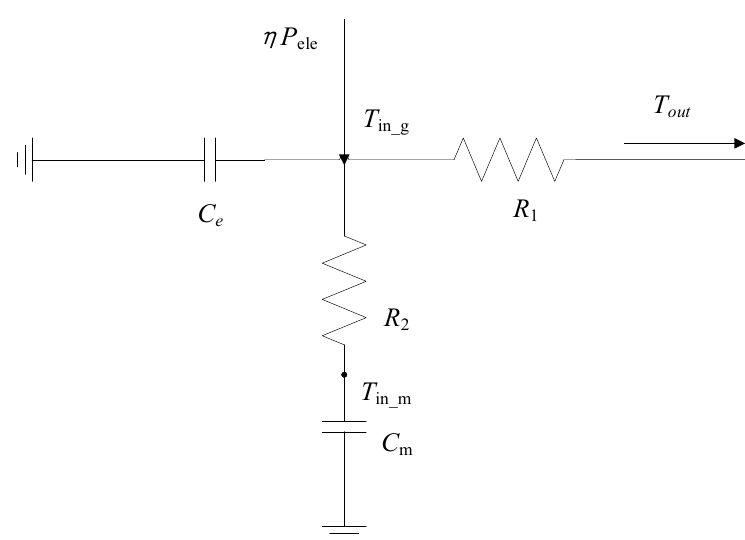
Figure 1. Second-order equivalent thermal parameter (ETP) model.